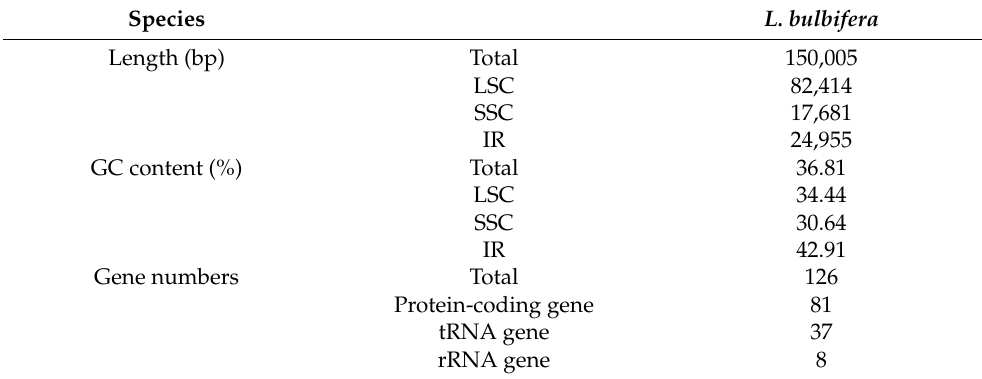
Table 1. Statistics on the basic features of plastome genome of L. bulbifera .